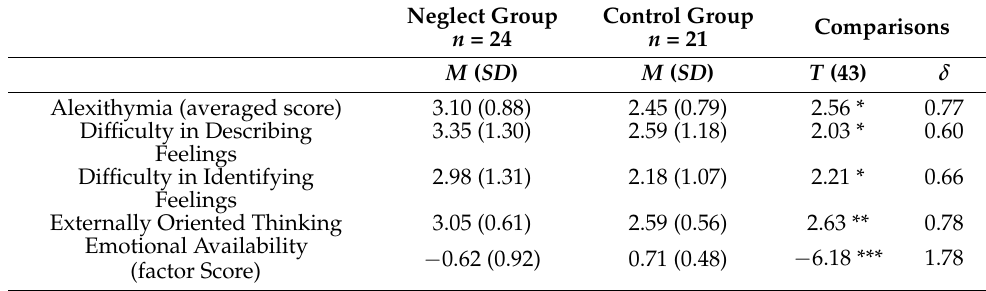
Table 2. Path analysis psychological variables. Alexithymia and Emotional Availability comparisons between Neglect and Control Groups. Neglect Group Control Group Comparisons n = 24 n = 21 M ( SD ) M ( SD ) T (43) δ Alexithymia (averaged score) 3.10 (0.88) 2.45 (0.79) 2.56 * 0.77 Difficulty in Describing 3.35 (1.30) 2.59 (1.18) 2.03 * 0.60 Feelings Difficulty in Identifying 2.98 (1.31) 2.18 (1.07) 2.21 * 0.66 Feelings Externally Oriented Thinking 3.05 (0.61) 2.59 (0.56) 2.63 ** 0.78 Emotional Availability − 0.62 (0.92) 0.71 (0.48) − 6.18 *** (factor Score)